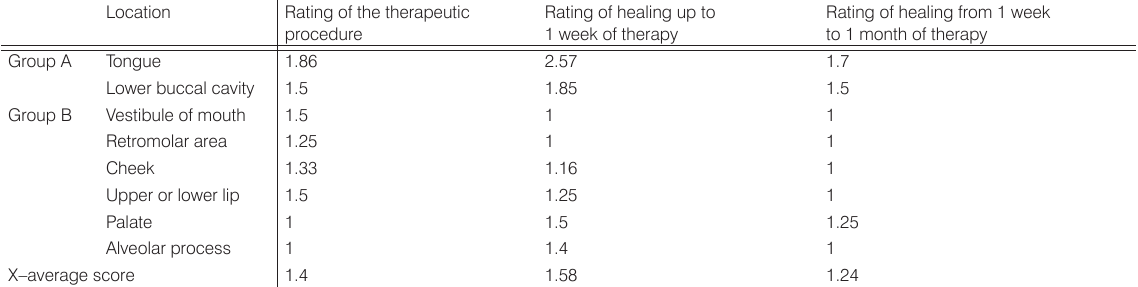
Table 10. Subjective evalution of therapy